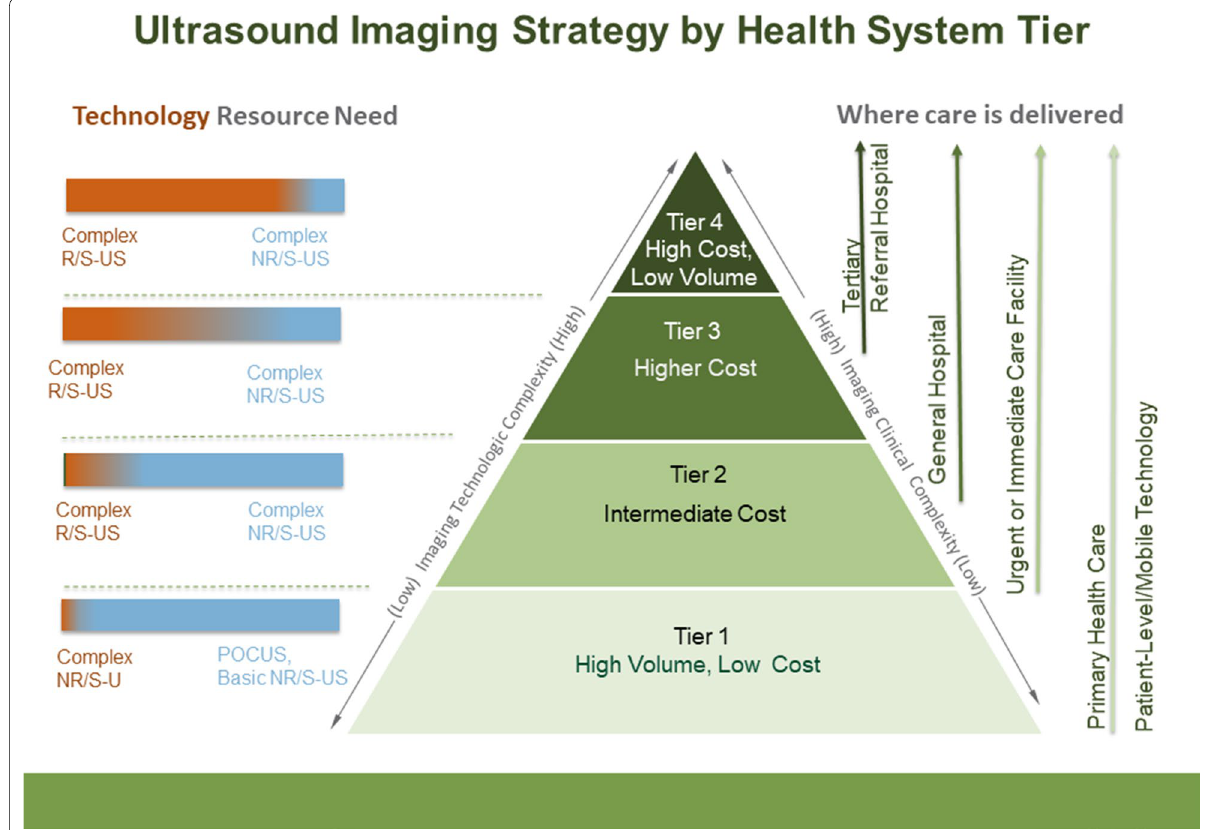
Fig. 3 Recommended ultrasound imaging strategy by health system tier. Higher levels on the pyramid denote increasing complexity. For each tier, red indicates a requirement for higher specialization of service (technology and personnel), while blue indicates lower specialization requirements (POCUS Point of Care ultrasound; NR/S‑US non‑radiologist/non‑specialist ultrasound; complex R/S‑US = =